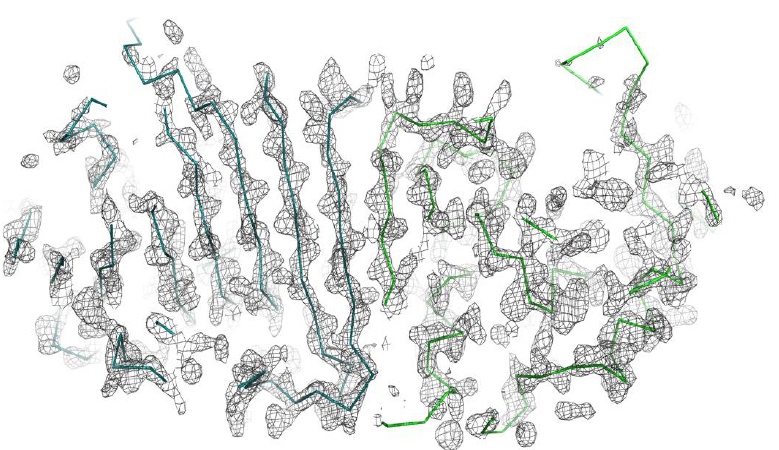
Figure 4. Electron density map of a portion of Ha Est1 structure contoured at 2 σ . The initially built Cα trace is shown in green and deep teal color for each chain. The figure was made with Pymol.